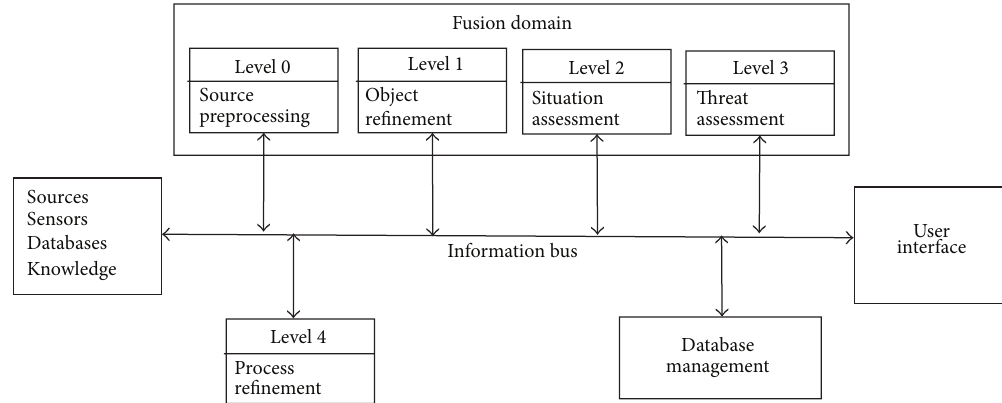
Figure 3: The JDL data fusion